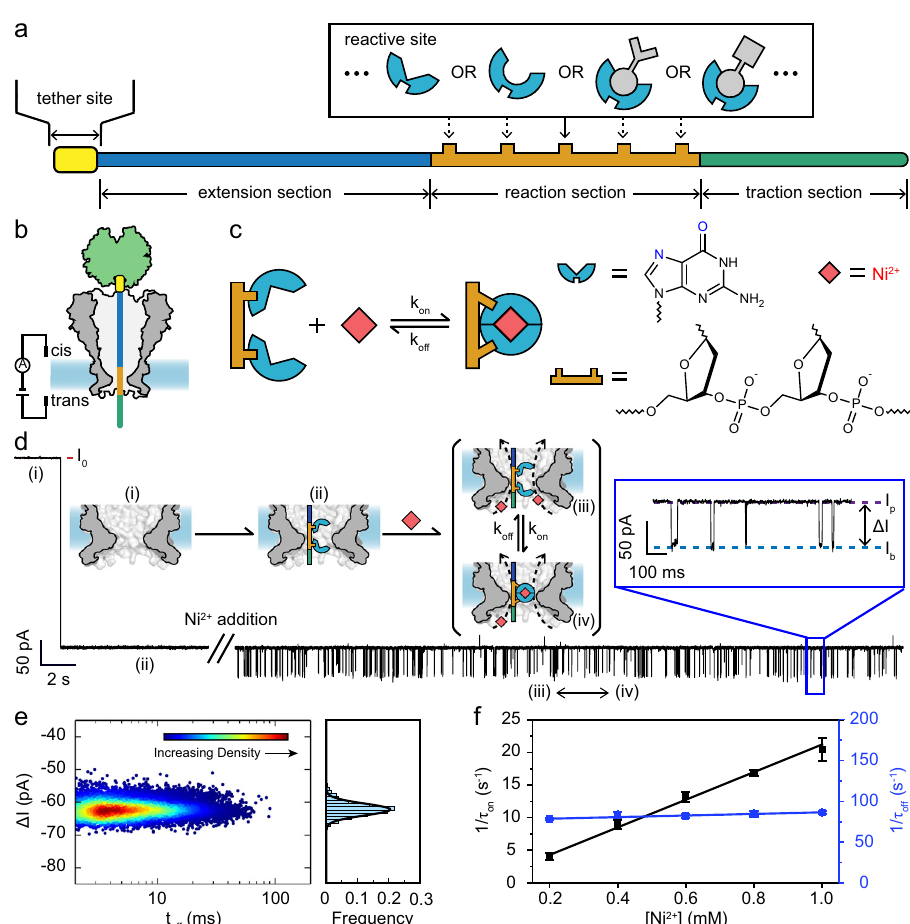
Fig. 1 Conceptual demonstration of PNRSS. a A PNRSS strand. A PNRSS strand is composed of functional modules as described. The reaction section, the